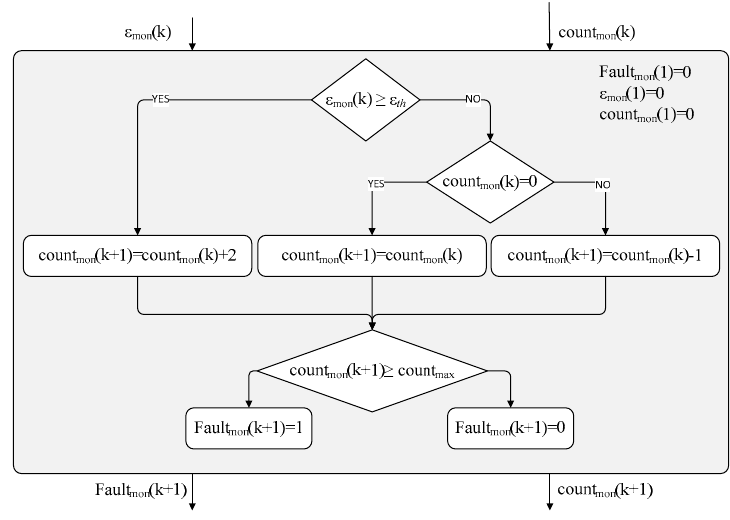
Figure 10. Flow chart of the condition-monitoring logic.